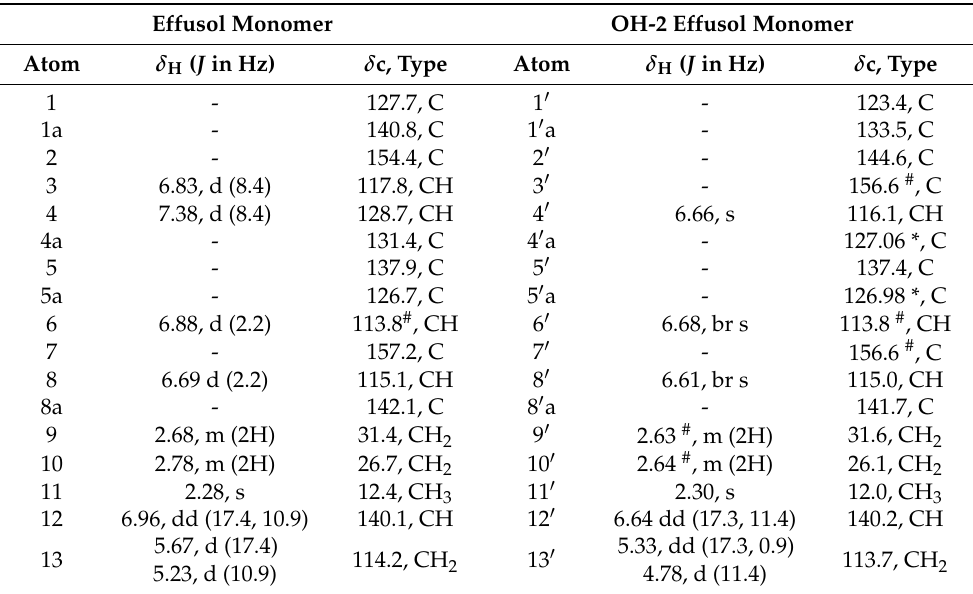
Table 2. 1 H (500 MHz) and 13 C (125 MHz) NMR data of compound 4 in methanol- d 4 . Effusol Monomer OH-2 Effusol Monomer